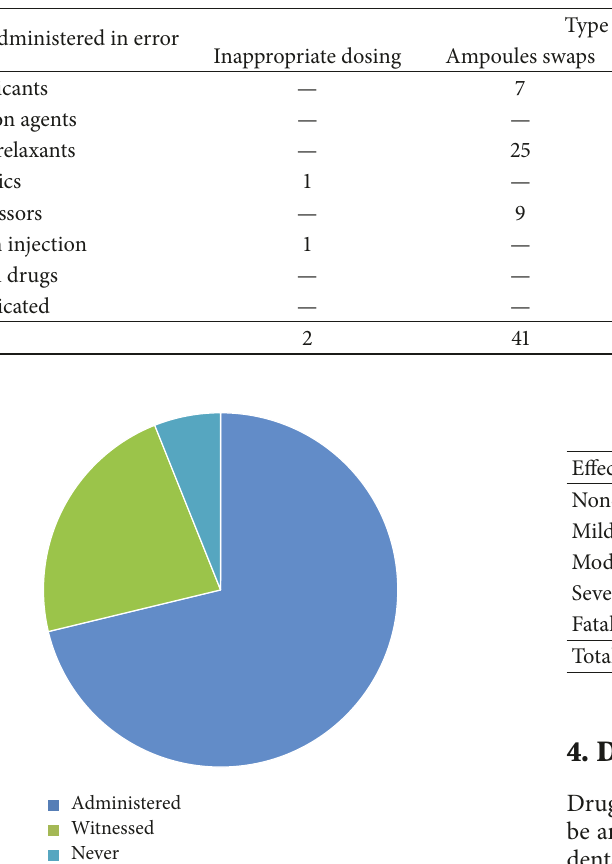
Table 1: Drug administered, type of error, and frequency.